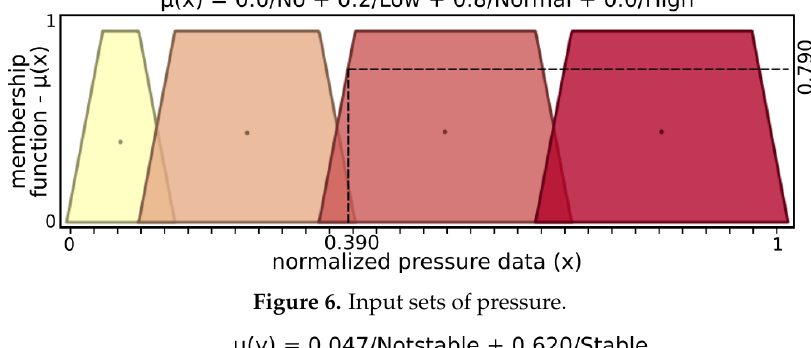
Figure 6. Input sets of pressure.